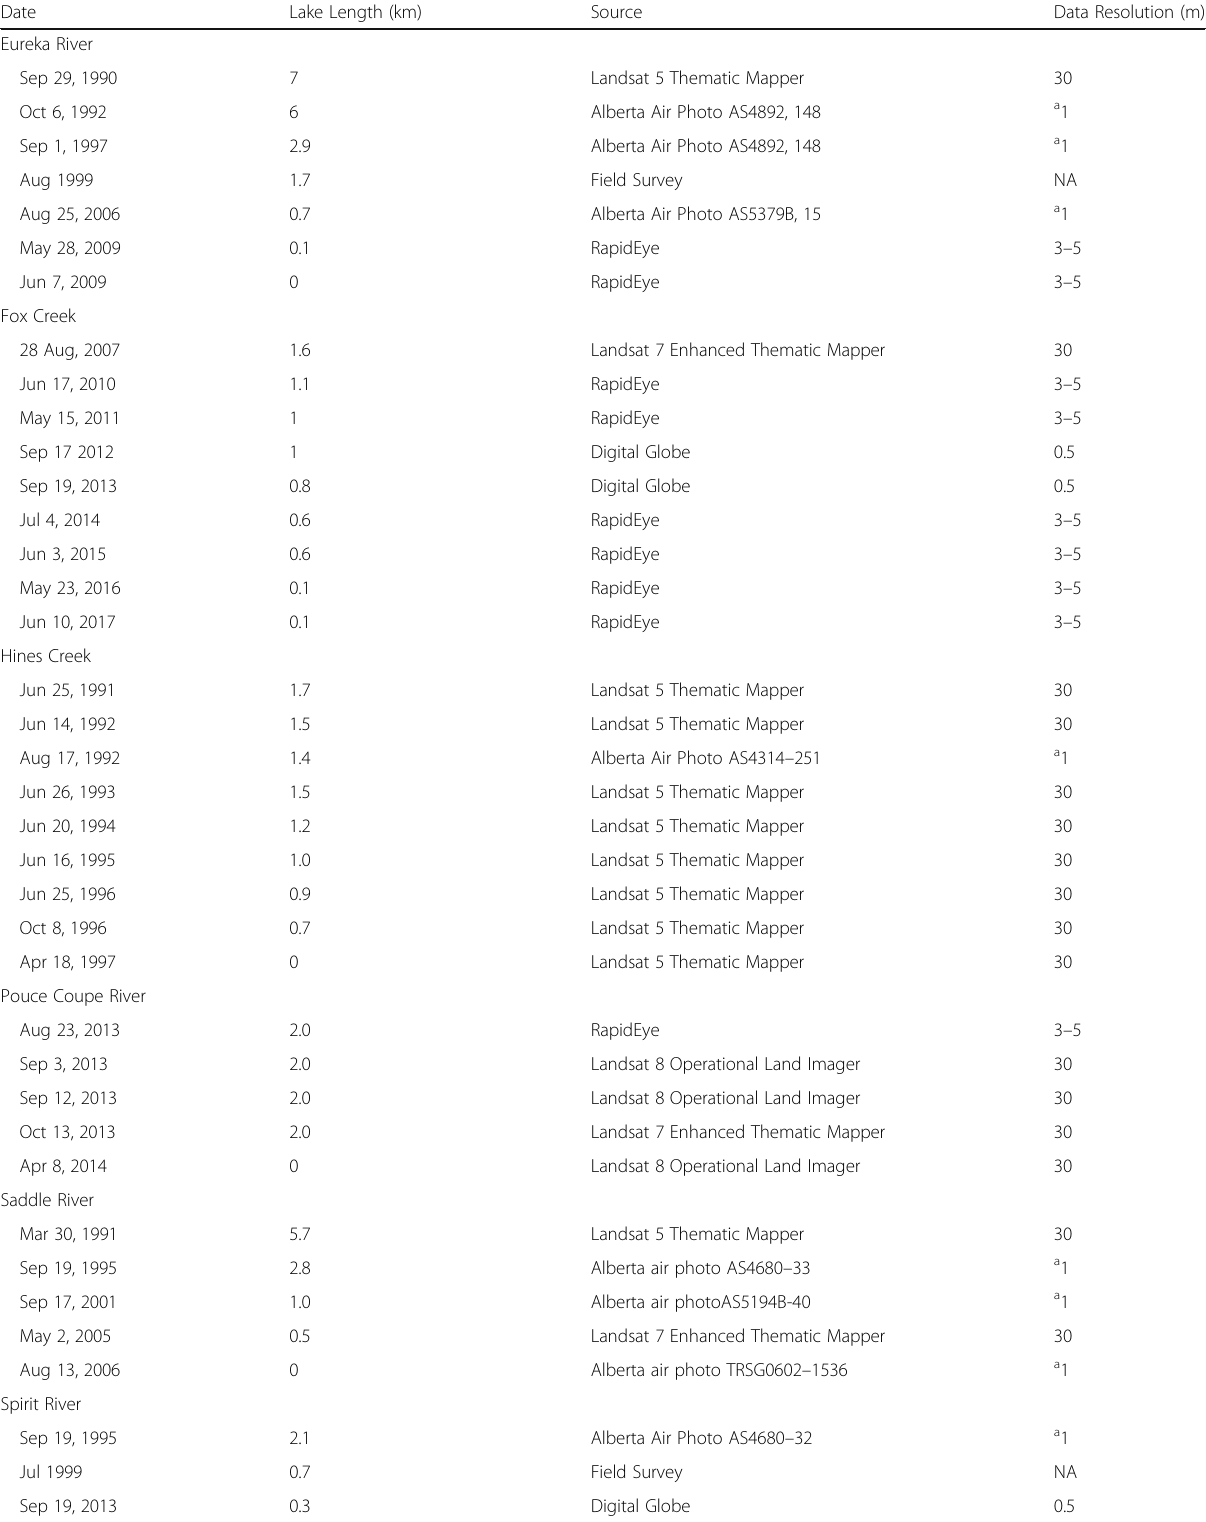
Table 2 Changes in the landslide lakes lengths over time with data sources and approximate ground resolution indicated